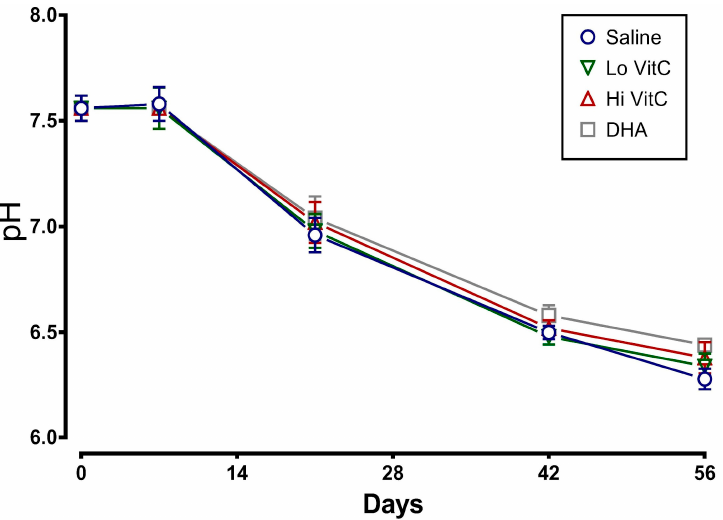
Figure 2. VitC exposure was associated with no changes in plasma pH. RBC concentrates showed a decline in plasma pH over 56 days of storage. The addition of reduced VitC (Lo/Hi) or oxidized VitC (DHA) did not alter the pH over the storage duration. ( N = 5/group, p > 0.05).